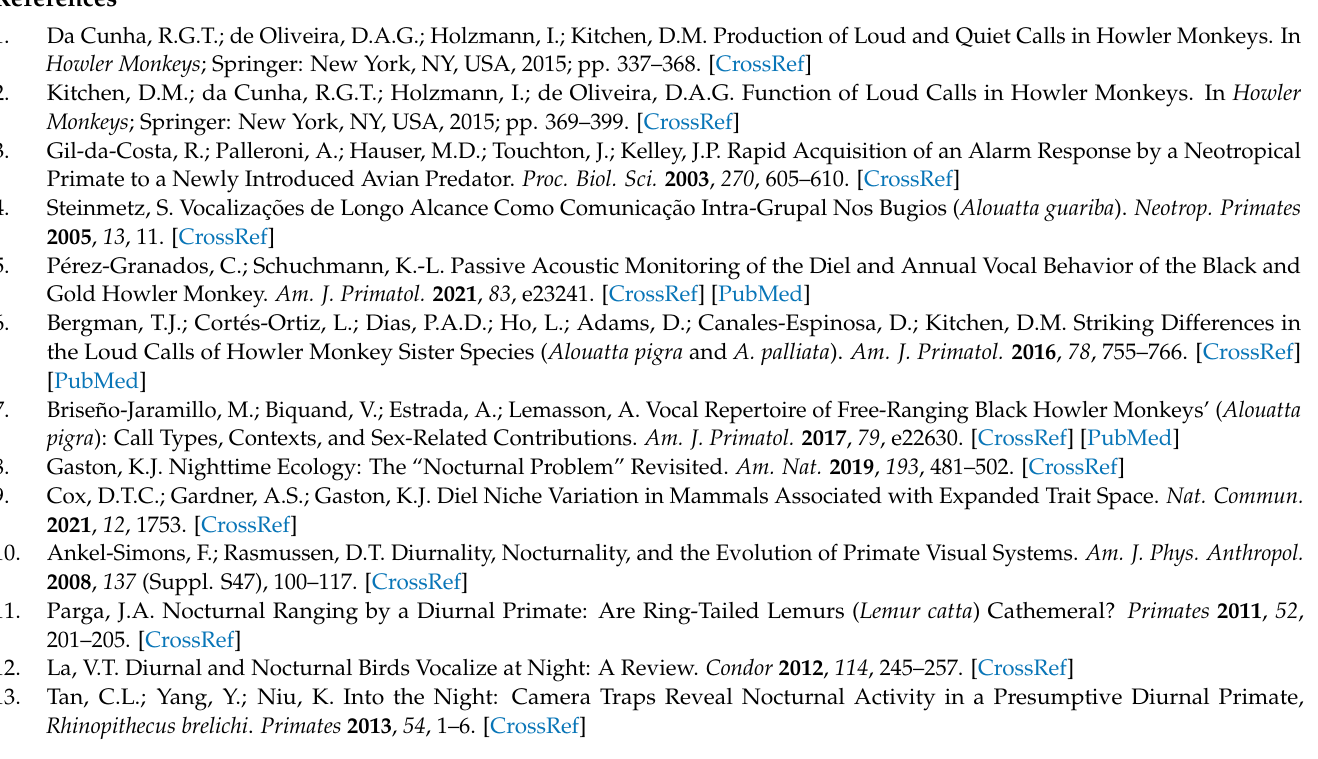
automatic classification; Figure S3: examples of howling bouts; Figure S4: Temporal distribution of the 102 howling bouts used in our acoustic analysis; Figure S5: examples of background noise at night and day; Figure S6: shows how the formants were calculated; Figure S7: diel vocal behavior from the manual validation